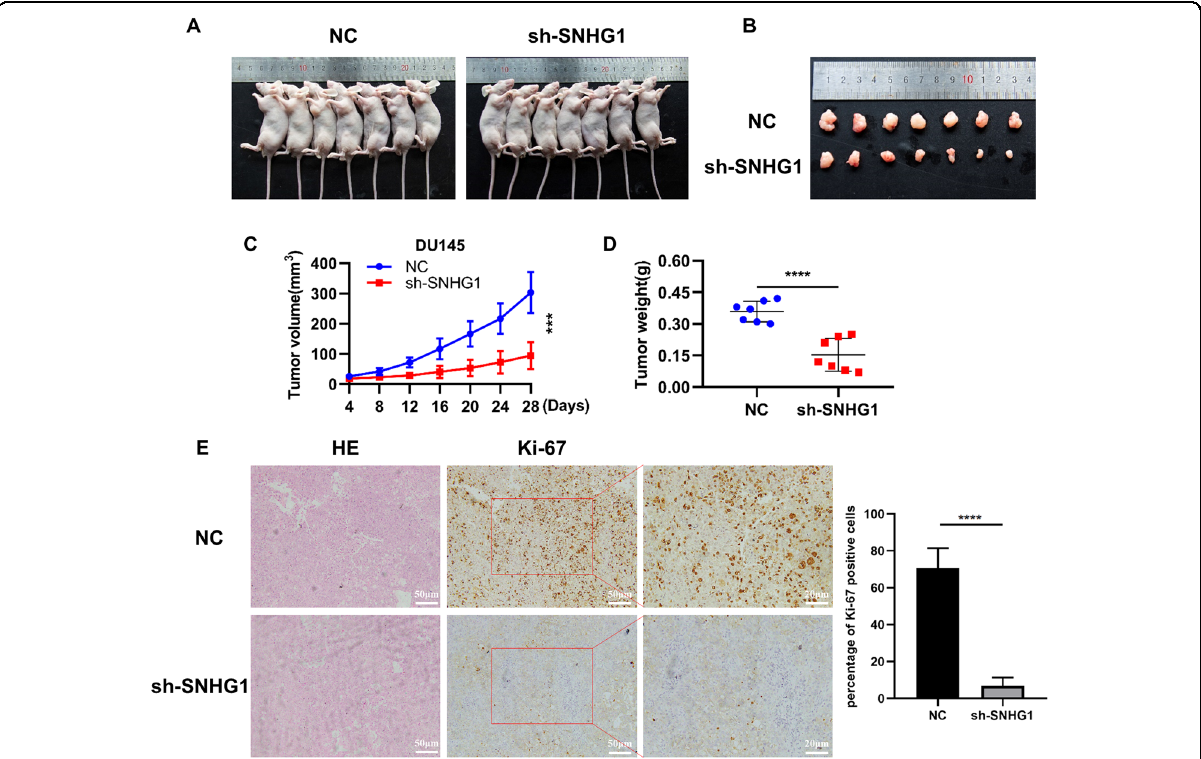
Fig. 3 Subcutaneous tumor formation in nude mice con fi rmed that silencing SNHG1 inhibited the proliferation of PCa cells in vivo. A , B Negative control or sh- SNHG1 was stably transfected into DU145 cells, which were injected into the nude mice. C Tumor volumes were calculated after injection every 4 days. D Tumor weights were represented as means of tumor weights ± SD. E IHC analyses of ki-67 con fi rmed that the proliferation of subcutaneous tumor was inhibited in sh- SNHG1 group. *** P < 0.001, **** P <